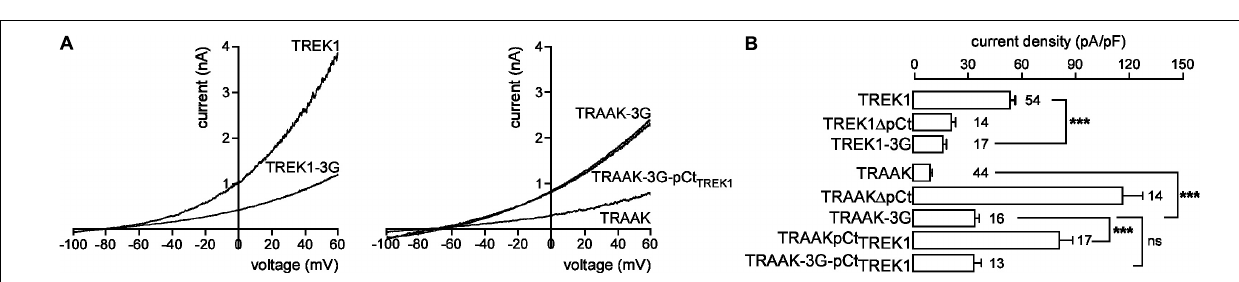
FIGURE 4 | Effect of decoupling pCt and M4 on TREK1 and TRAAK. (A) Representative whole-cell recordings of HEK cells expressing wild-type or mutated channels. Voltage ramps were applied from –100 to 60 mV from a holding potential of –80 mV. (B) Current densities at 0 mV. Data are presented as mean ± SEM. ∗∗∗ p < 0.001, and ns, not significant. The number of cells is indicated (one-way Anova with Tukey’s